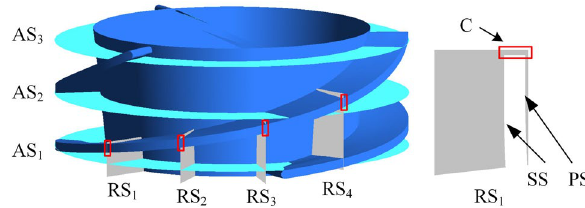
Figure 9. Schematic diagram of the sections in the impeller.